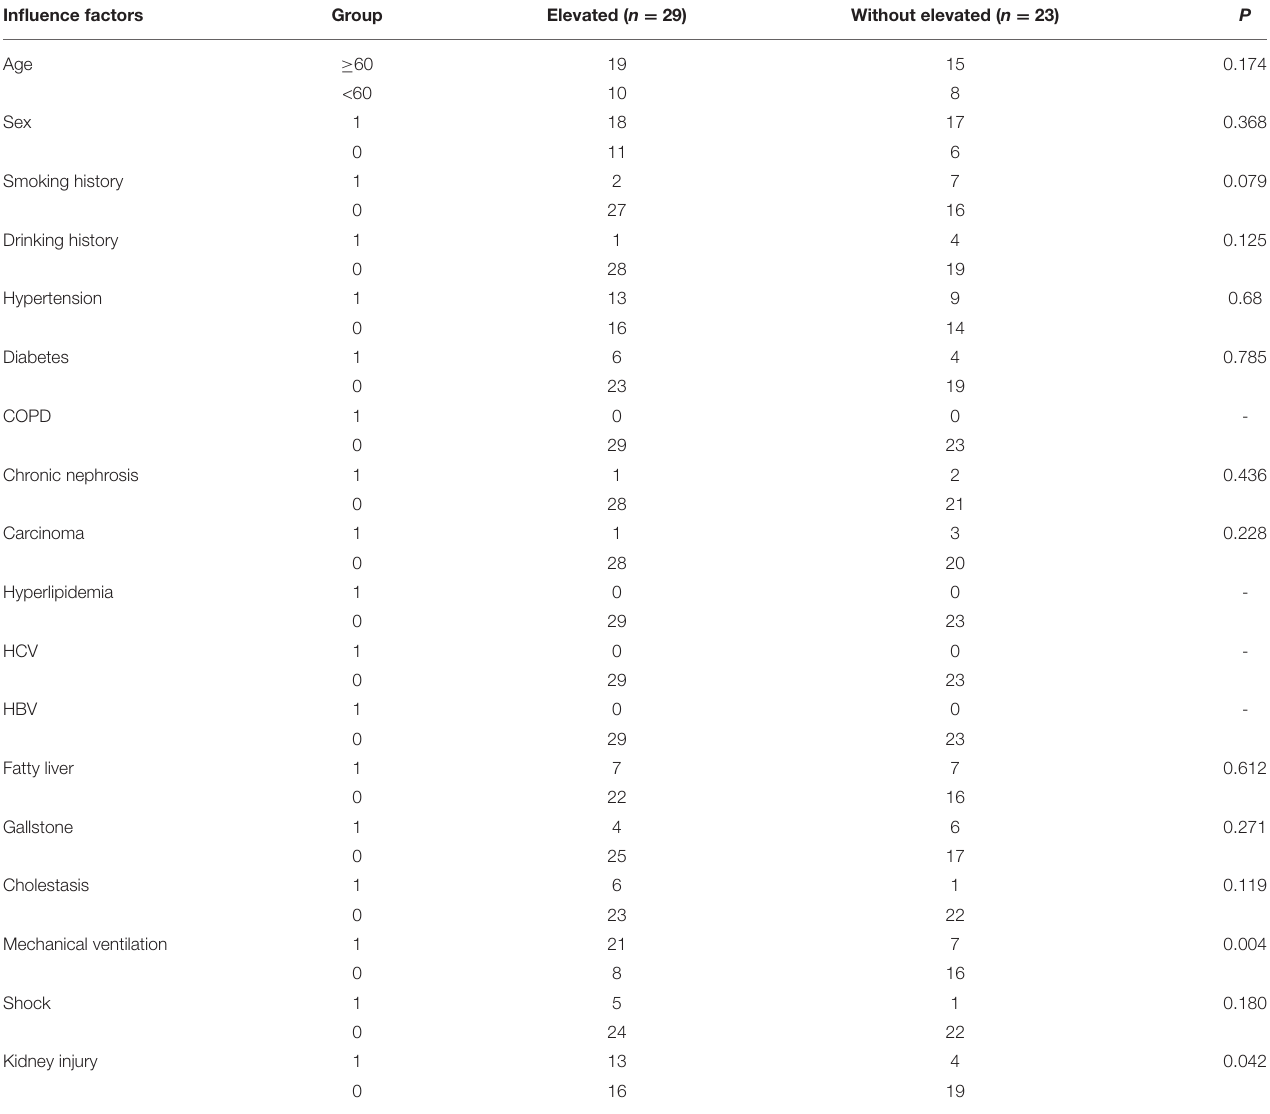
TABLE 7 | Univariate analysis of elevated pancreatic enzymes in COVID-19 patients ( n = 52). Influence factors